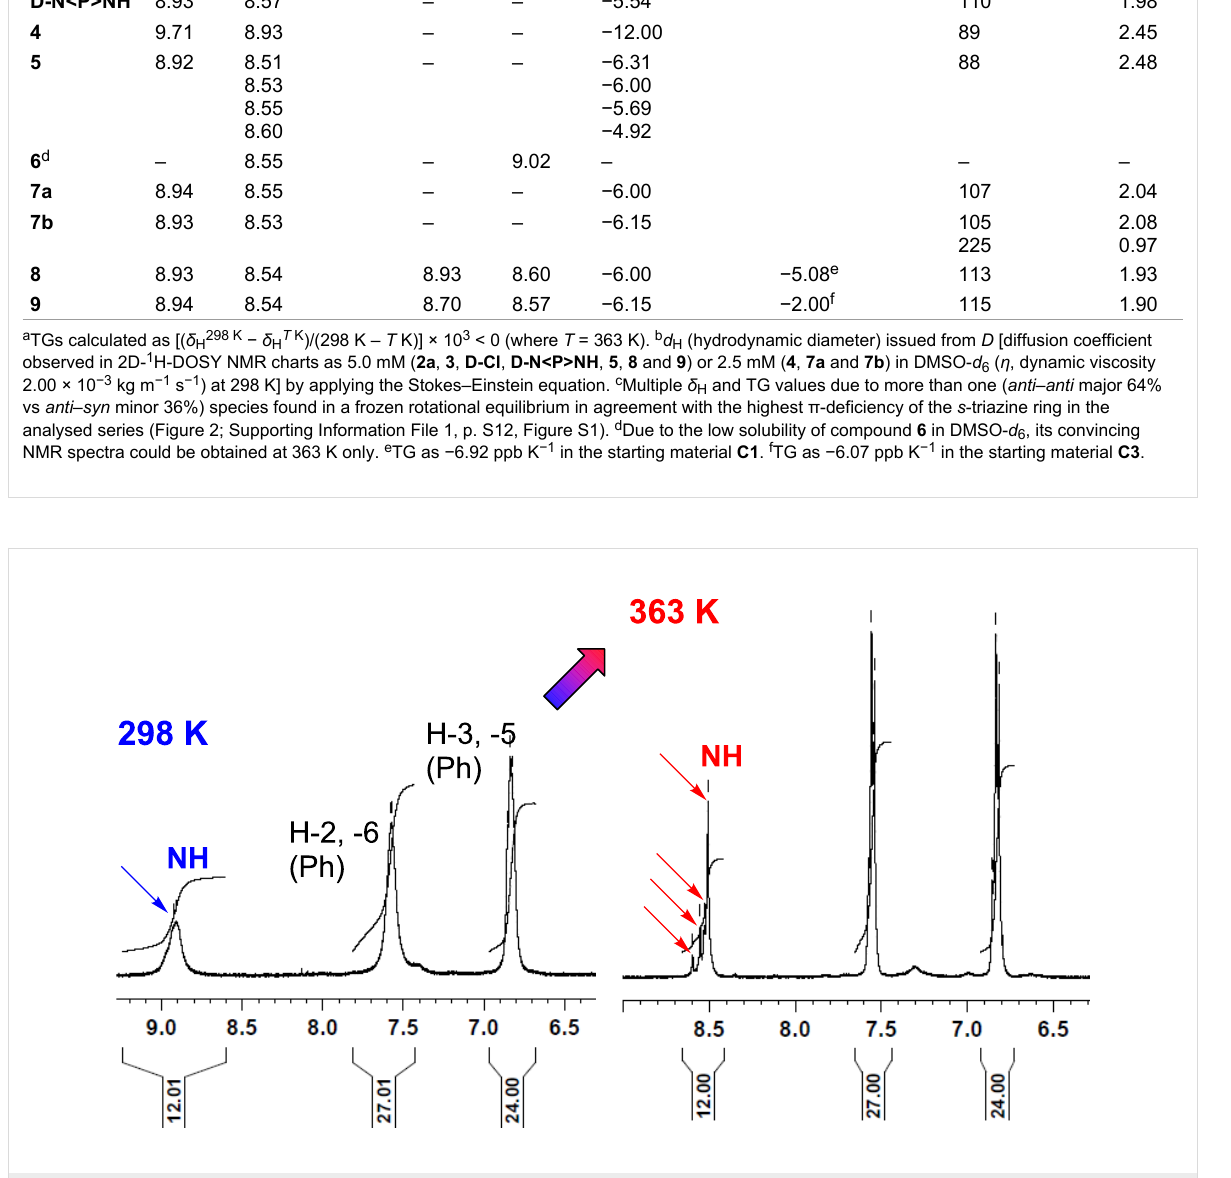
Figure 3: Comparative details from 1 H NMR spectra of G-2 dendrimer 5 (500 MHz, 5.0 mM in DMSO- d 6